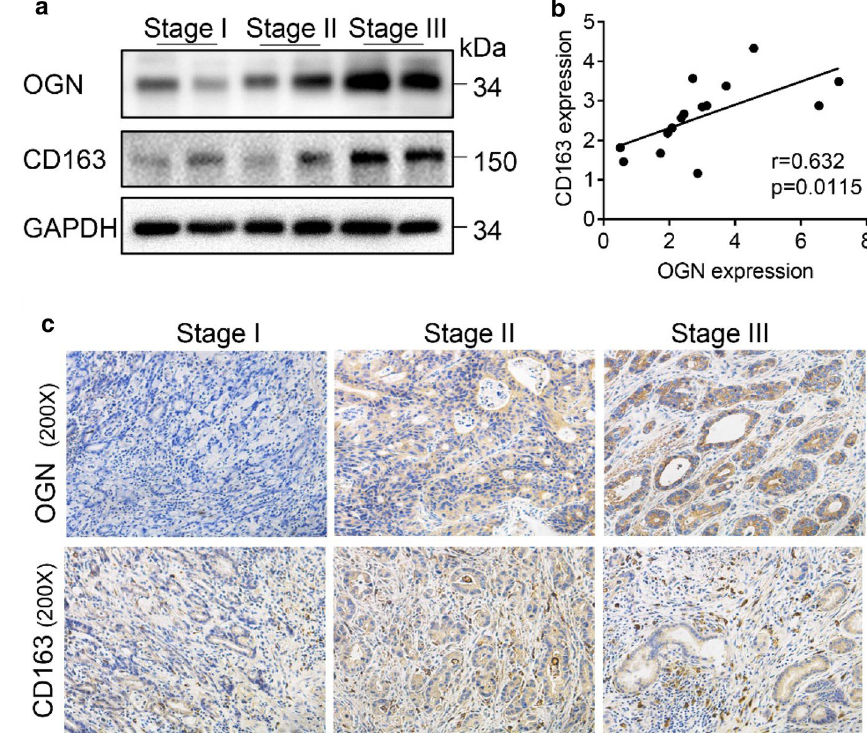
Fig. 5 Expression of OGN and its relationship with M2 mac- rophage in different stages of GC. a Western blot showed the expression of OGN and CD163 (marker of M2 mac- rophage) in different stages of GC. b Correlation analysis verified OGN was positively related with CD163 in GC. c Representative images of OGN and CD163 in different stages of GC detected by immuno- histochemistry